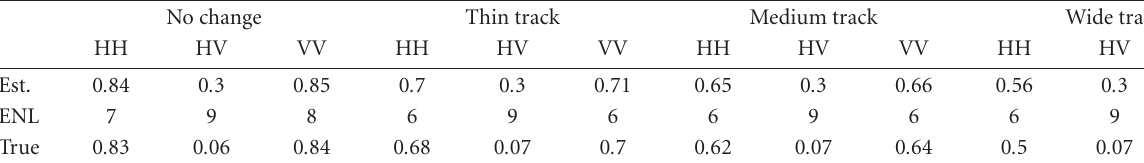
Table 1: Estimated and underlying coherency values recovered from simulation. The three columns to the left indicate coherence by po- larimetric channel for the case of no change in the surface, but an e ff ective coherence “noise” of − 7 . 2 dB in the HH channel. The following columns indicate coherencies by polarimetric channel for changes corresponding to three types of tyre track: thin, medium, and wide, described in Table 2.